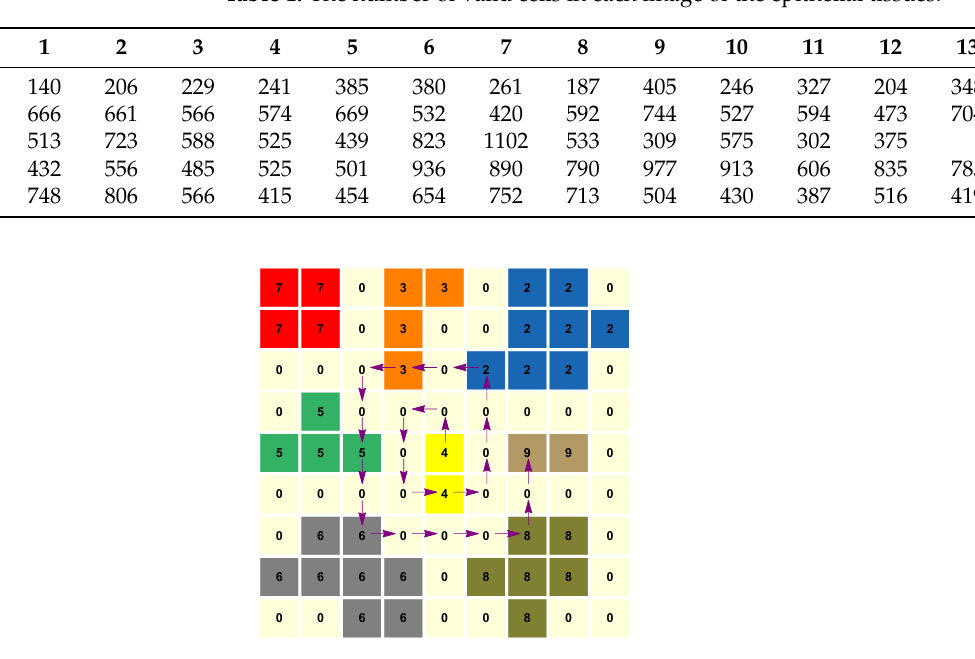
Table 1. The number of valid cells in each image of the epithelial tissues.